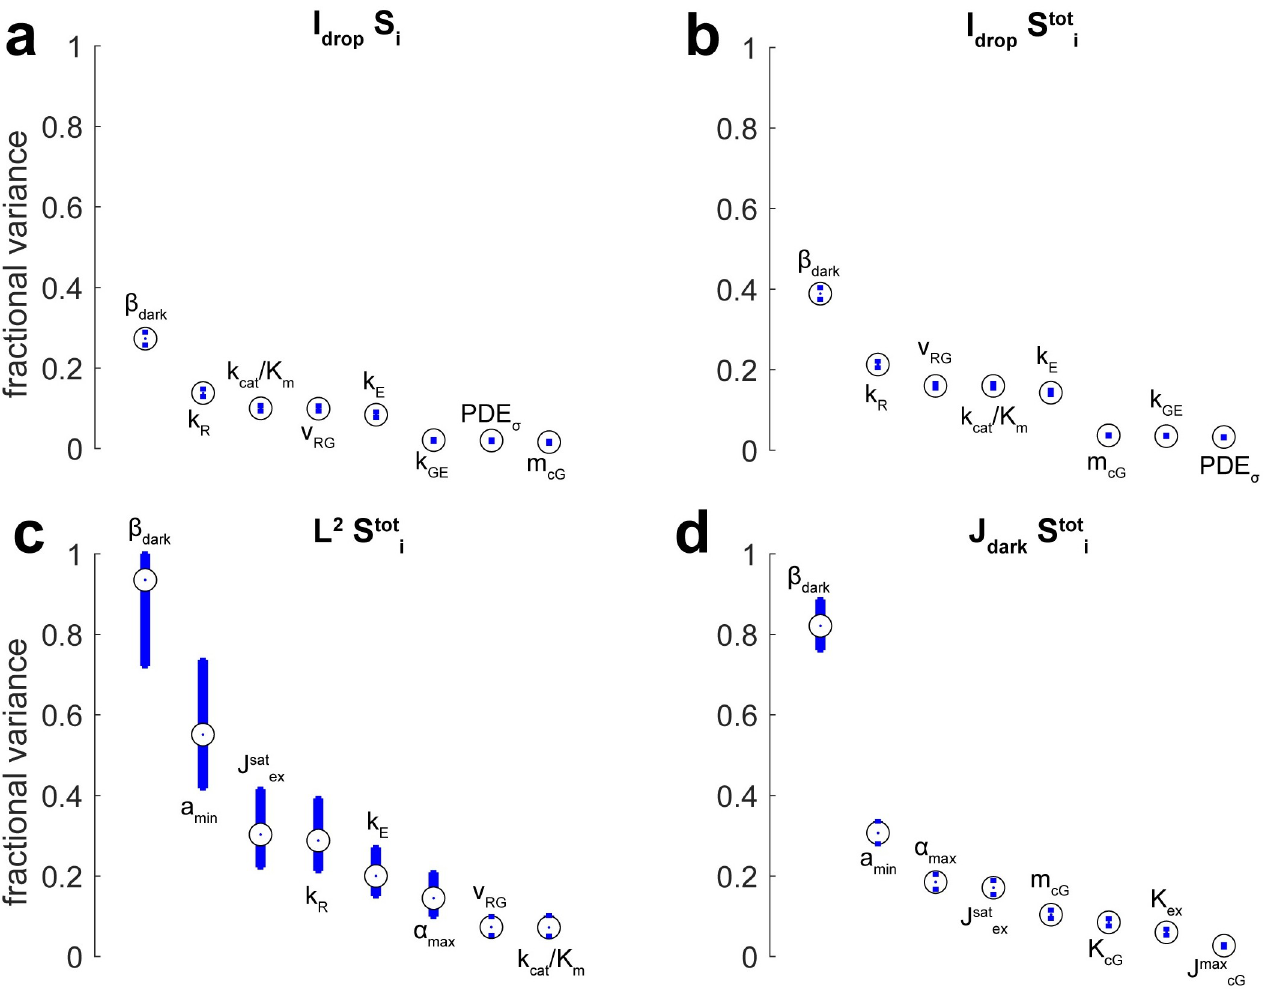
Fig 3. Sobol indices for functionals quantifying the drop in current due to flash response, the rms error between simulation and experiment, and the dark current. Blue bars define a 90% confidence interval (100,000 samples). Plots show the eight most influential parameters. Confidence intervals could be off-center of the estimated Sobol index, because the indices were ratios of two Monte Carlo estimated quantities. (a) Single sensitivity indices for the current drop. (b) Total sensitivity indices for the current drop. (c) Total sensitivity indices for the rms error between model prediction and experiment. (d) Total sensitivity indices for the circulating dark